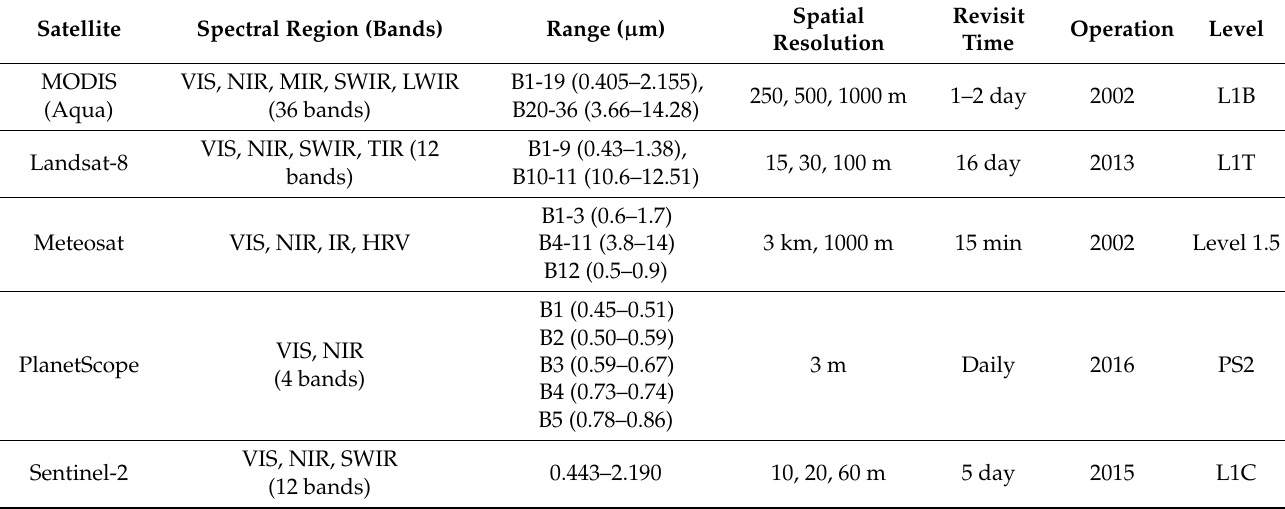
Table 4. List of satellite data used in this